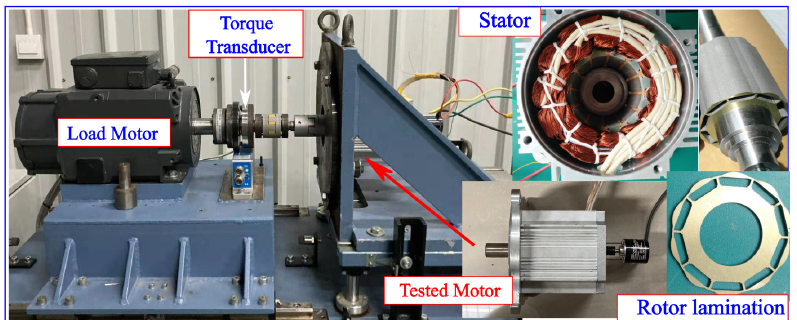
Figure 18. The prototype and the corresponding test